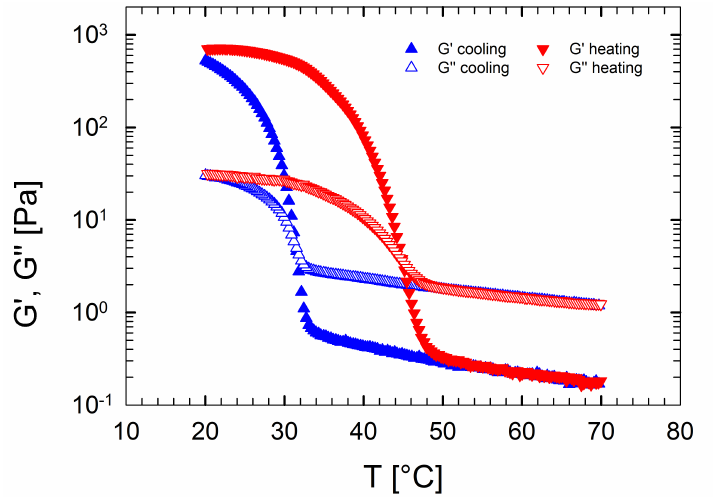
Figure 2. Inverse vial experiment. Visual observation of aqueous κ -c solutions at different biopolymer contents, as indicated in the legend. Picture is taken at room temperature, of samples kept in the refrigerator at 5 ◦ C for 24 h.